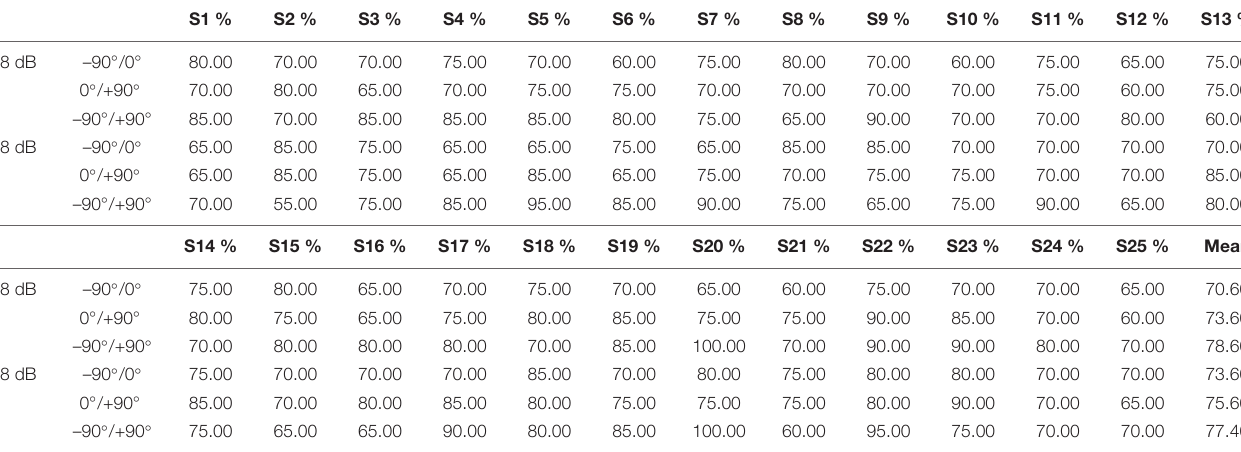
TABLE 3 | Classification accuracies of each participant using an optimal selected feature set for oxy-Hb response (–90 ◦ /0 ◦ /+90 ◦